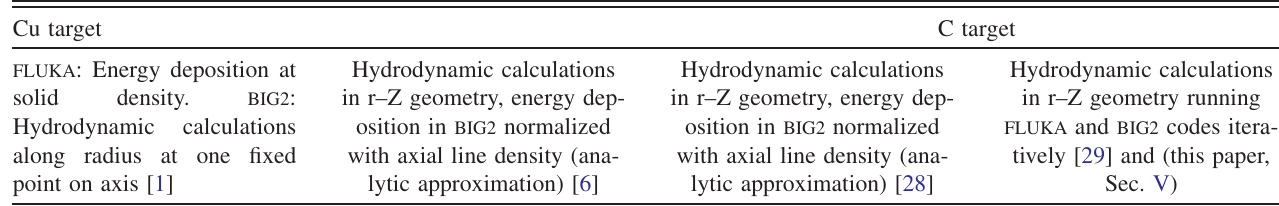
TABLE III. Overview of LHC